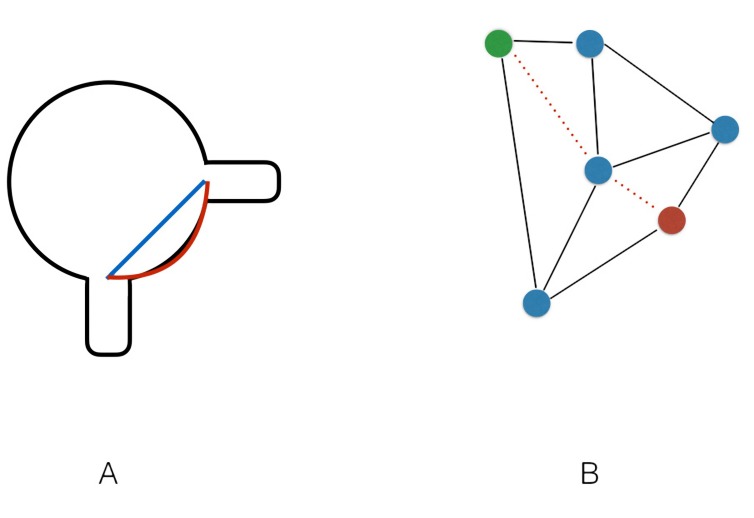
(A) Two-dimensional cross-sectional representation of a vessel showing the difference between a linear measurement and a measurement along a surface; (B) Two-dimensional representation of a polygonal mesh and the algorithmic method for calculating the shortest distance between points.